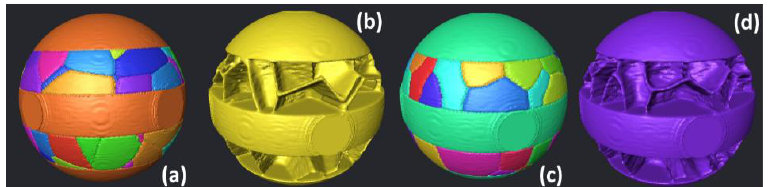
Figure 11. Generation of a 3D cellular structure containing excluded regions using Voronoi–Monte Carlo scheme ( a ) Voronoi structure, ( b ) cellular network based on Voronoi close-cell boundaries, ( c ) Voronoi–Monte Carlo structure after 70 MCS, and corresponding ( d ) cellular structure.